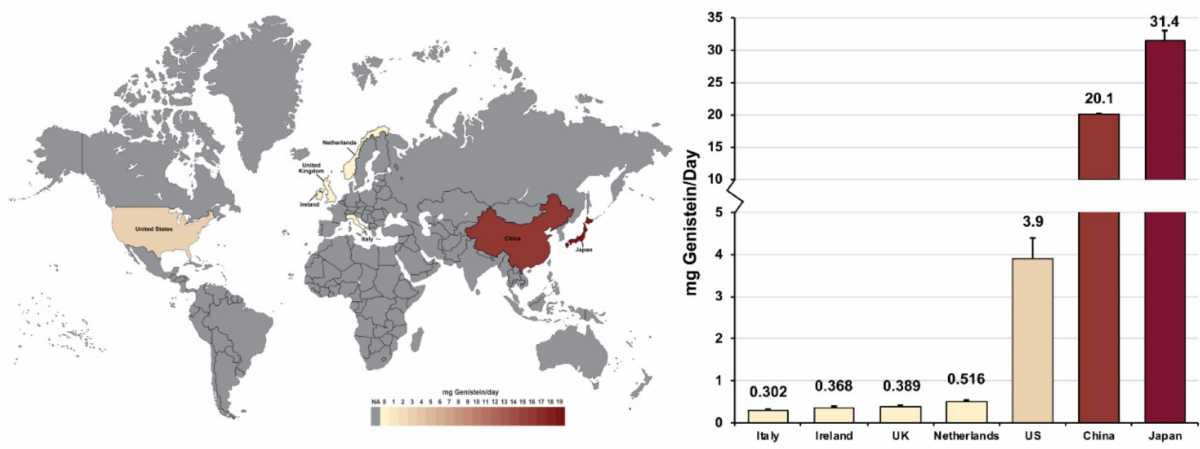
Figure 1. Heatmap showing daily genistein consumption levels across 7 surveyed countries. Data from